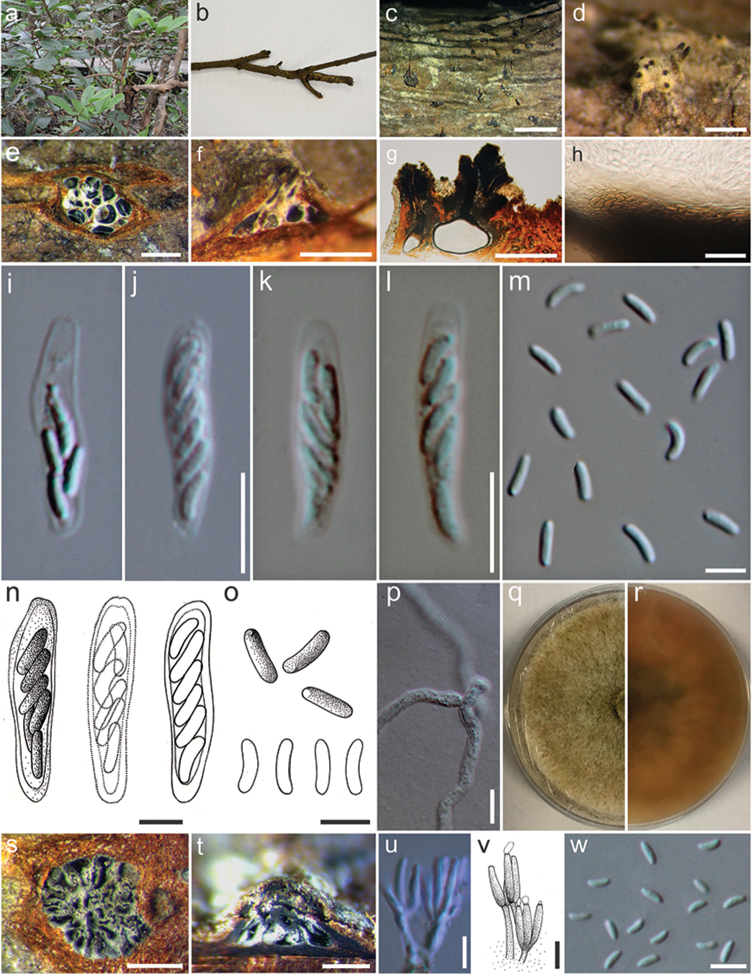
Cytosporaxylocarpi (MFLU 17-0708, holotype). aXylocarpusgranatumb Branch of XylocarpusgranatumcAscostromata on host substrate d Surface of ascomata e Transverse sections through ascostroma to show distribution of locules f, g Longitudinal sections through ascostroma to show distribution of locules hPeridiumi–l, n Asci m, oAscosporesp Germinating spore q, r Colonies on MEA (q-from above, r-below) s Transverse sections through conidioma to show distribution of locules t Longitudinal sections through conidioma to show distribution of locules u, v Conidiogenous cells with attached conidia w Mature conidia. Scale bars: c = 2000 µm, d–f = 500 µm, g = 200 µm, h = 20 µm, i, p = 10 µm, j–o, u–w = 5 µm, s, t = 400 µm.